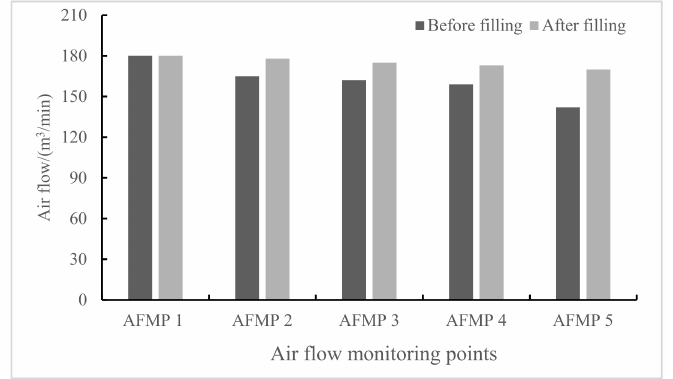
Figure 15. The variation in the airflow in the monitoring points of the working face before and after